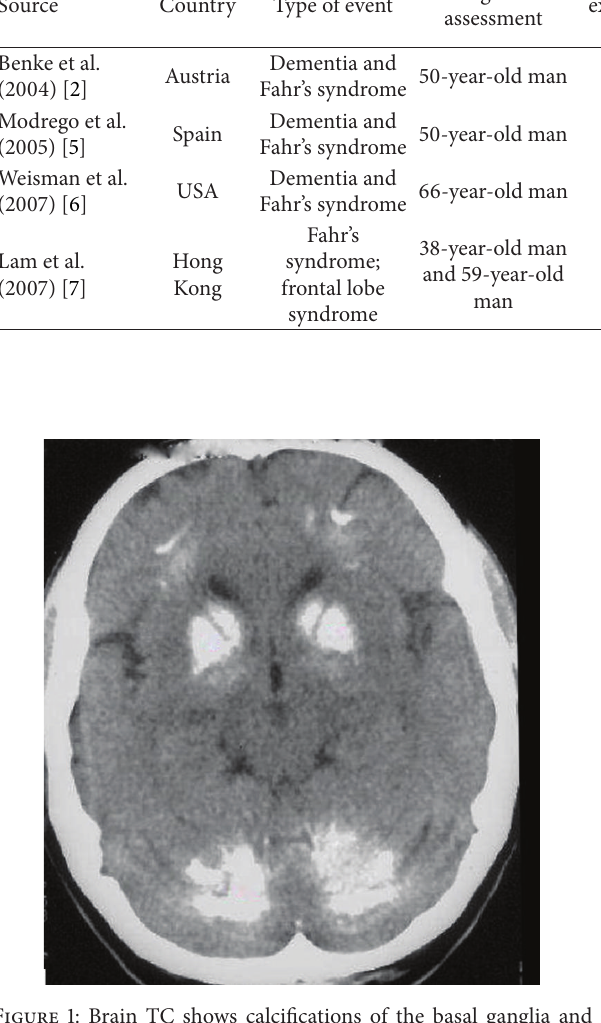
Figure 1: Brain TC shows calcifications of the basal ganglia and dentate nucleus of